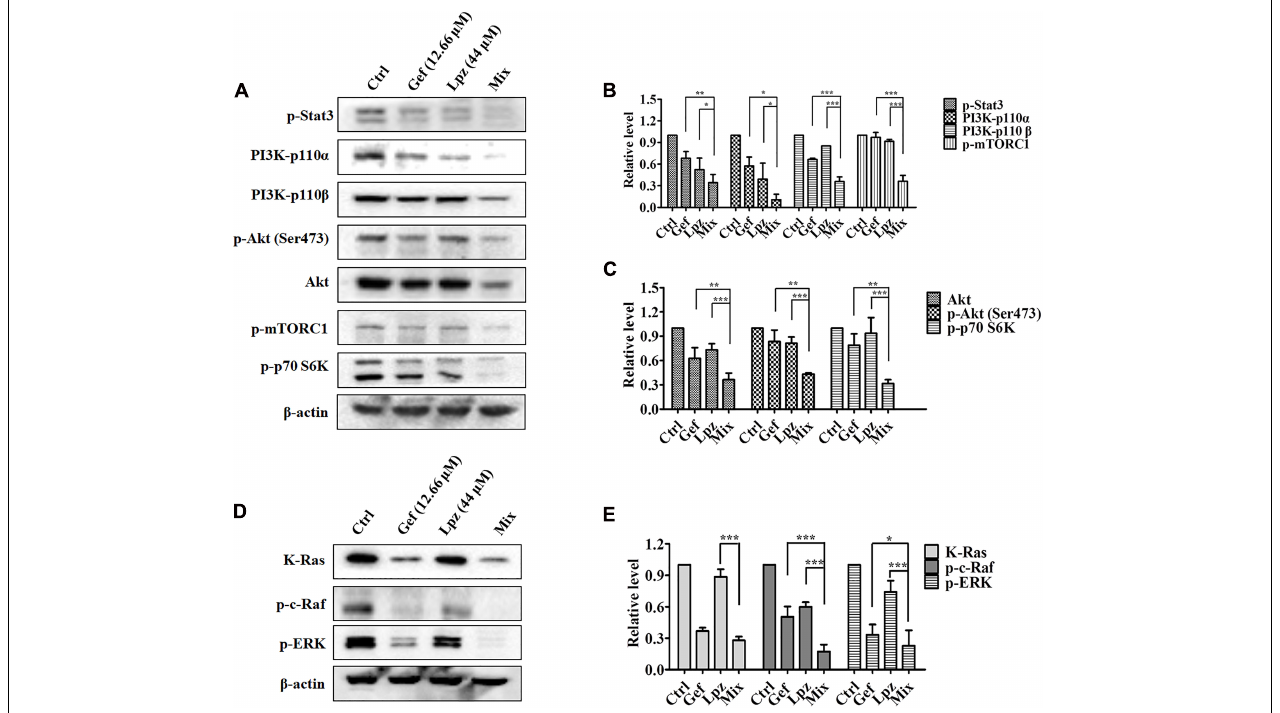
FIGURE 5 | The combination of Lpz and Gef synergistically inhibits phosphorylation of the Stat3, PI3K/Akt/mTOR, and Ras/Raf/ERK pathways. (A) Lpz and Gef suppressed the phosphorylation of Stat3, Akt, mTOR, and p70 S6K and the expression of PI3K. (B,C) Quantification of the results in panel (A) . (D) Lpz and Gef suppressed the expression of K-Ras and phosphorylation of c-Raf and ERK. (E) Quantification of the results in panel (D) . Data shown are the mean ± SD of three independent experiments. *: p < 0.05, **: p < 0.01, and ***: p <